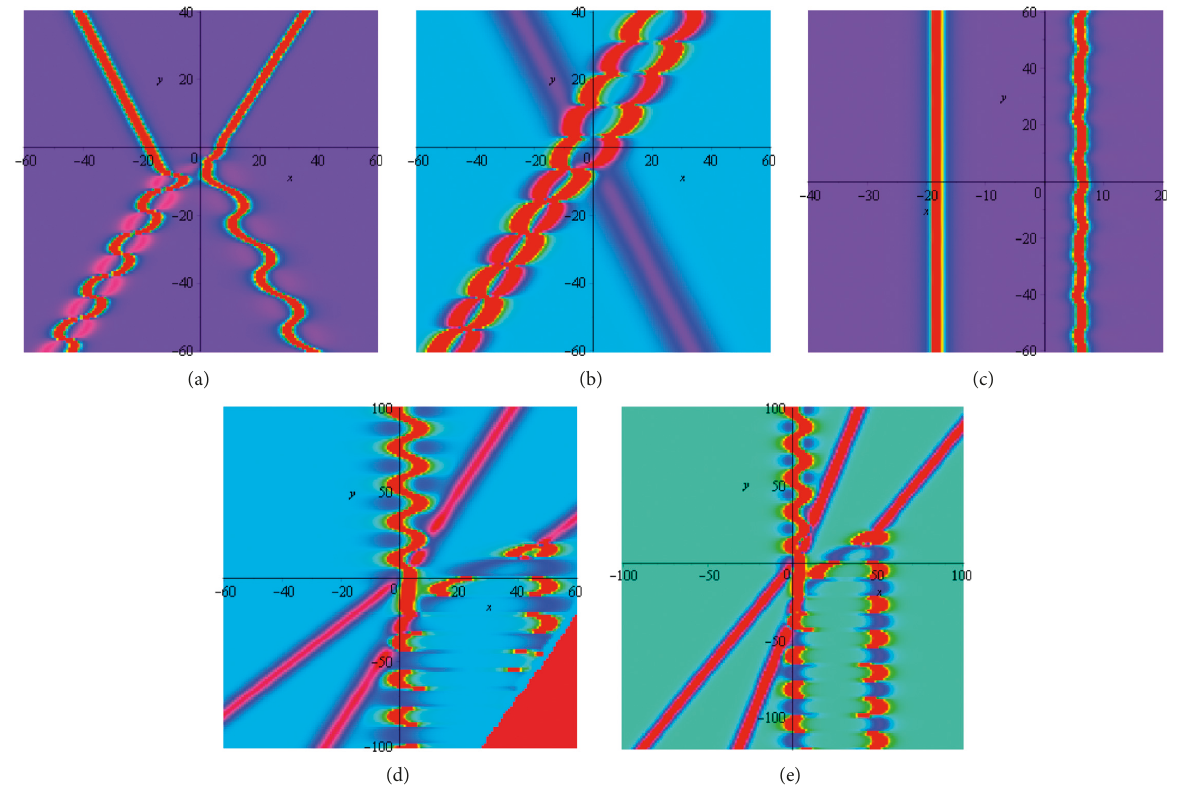
Figure 18: Plots of equation (75) by utilizing ϕ